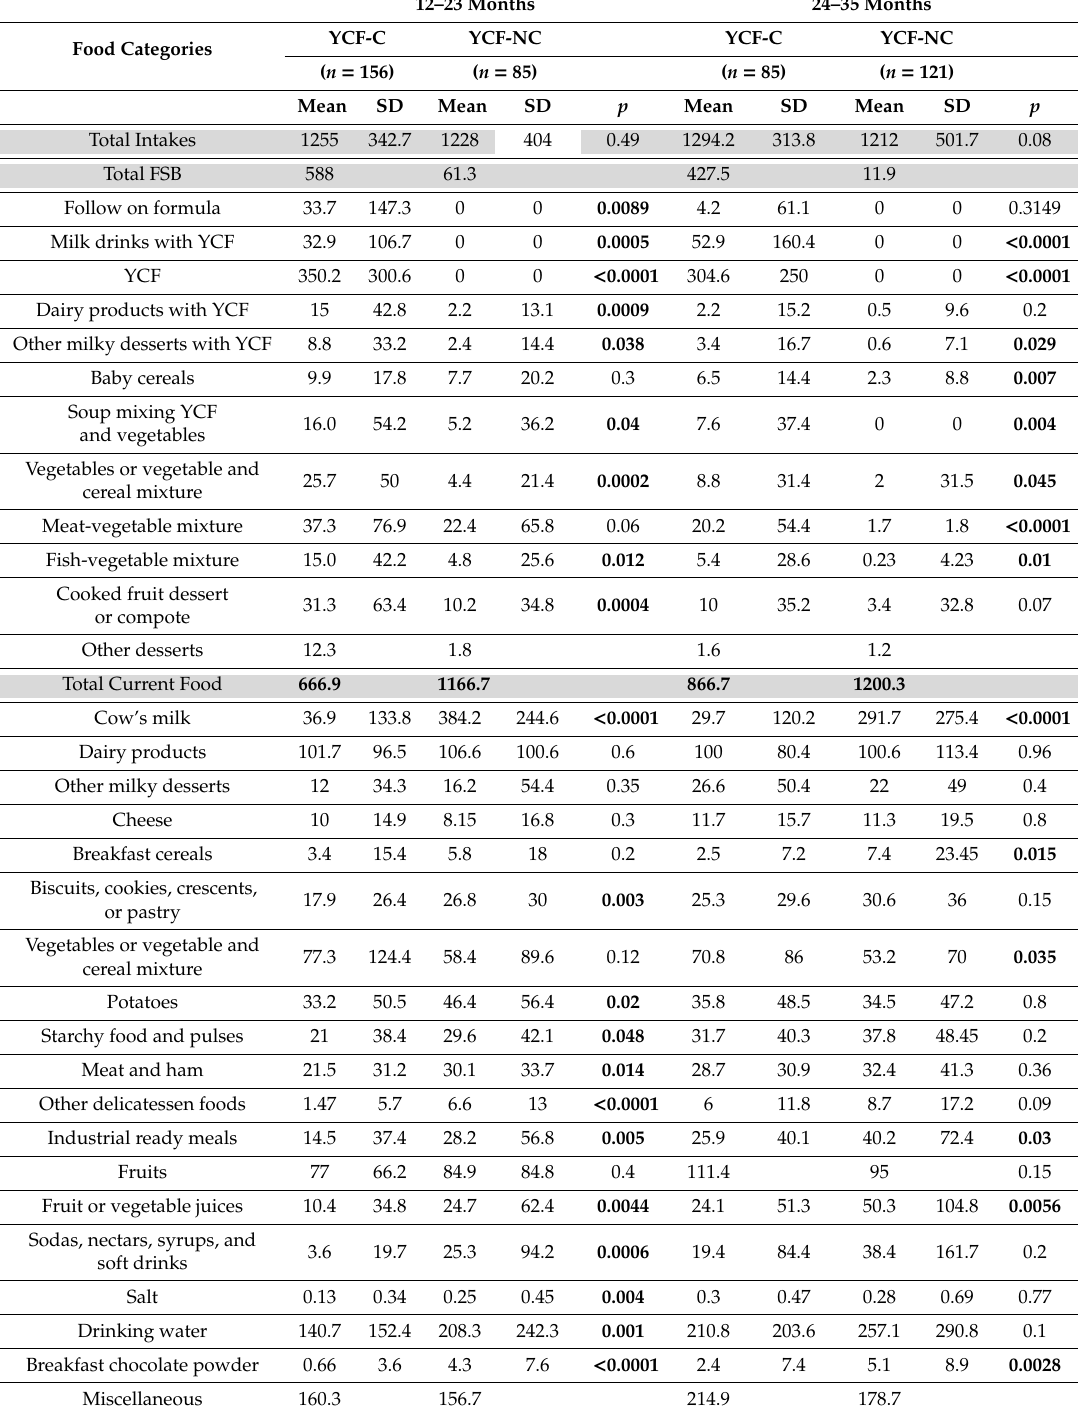
Table 3. Food categories consumed by YCF-C and YCF-NC in the two age groups (12–23 months and 24–35